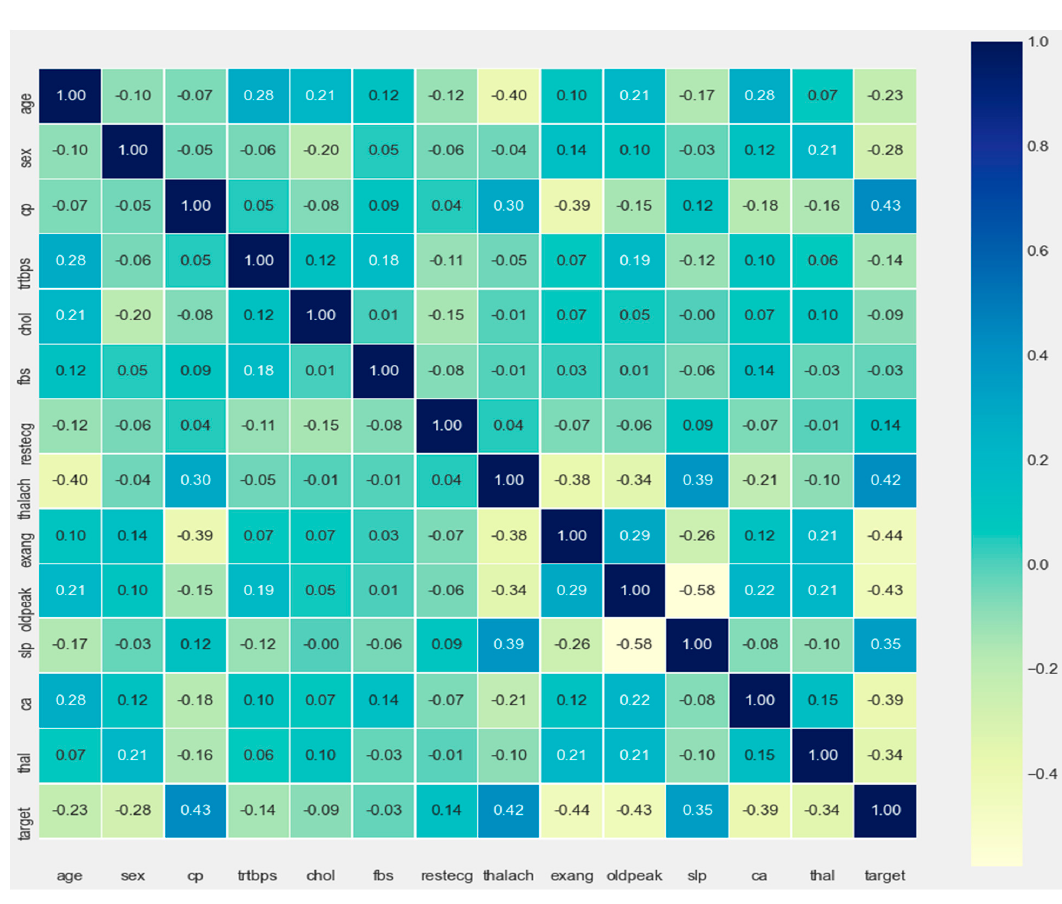
Figure 6. The heart disease datasets heat map for correlation characteristics. Table 4. Analytical results of various types of training and testing datasets of traditional ML models.